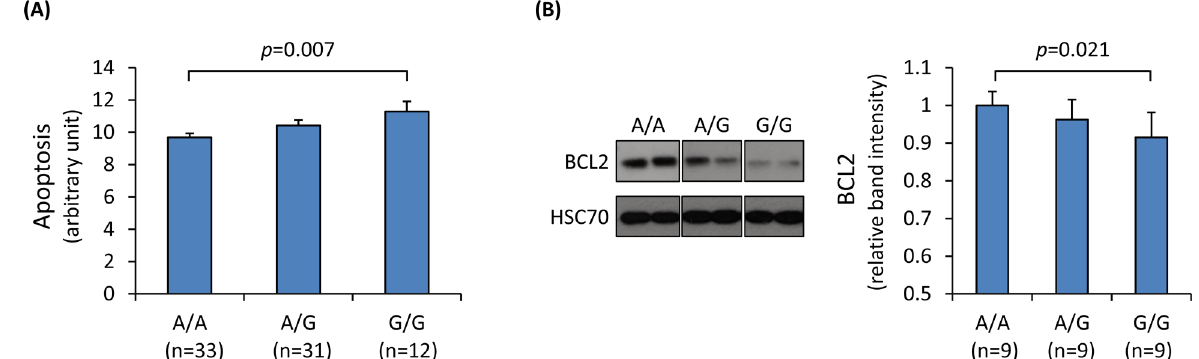
Fig 4. Influence of SNP rs4773144 genotype on apoptosis. (A) Primary cultures of SMCs from different individuals were genotyped for rs4773144 and subjected to apoptosis assay. Shown in the graph are relative differences in cell apoptotic rate in different genotype groups. Columns and error bars represent mean and SEM values; p -values shown are for an additive genetic model. (B) Primary cultures of ECs of different genotypes for rs4773144 were subjected to immunoblot analysis of the anti-apoptotic protein BCL2. Shown on the left are representative immunoblot images and on the right a graphic presentation of BCL2 band intensities standardized against band intensities of the loading control HSC70. Columns and error bars represent mean and SEM values; p -values shown are for an additive genetic